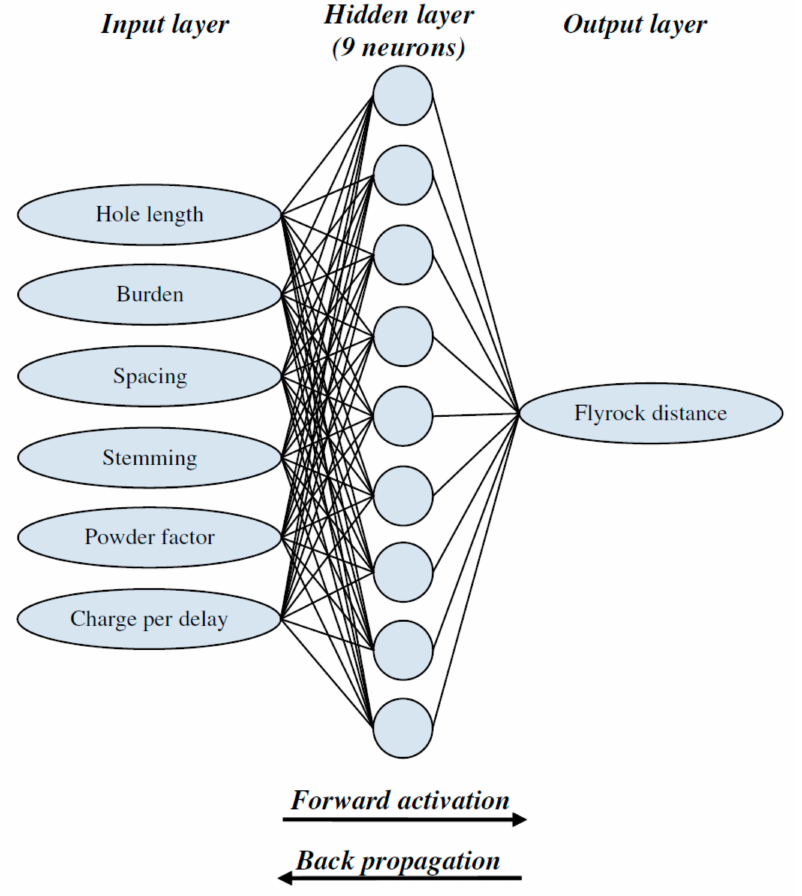
Figure 7. Artificial neural network architecture